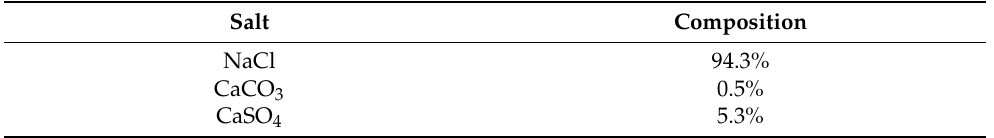
Table 13. Composition of the salts recovered from the conventional ZLD system for 1000 kg/h of feed brine.